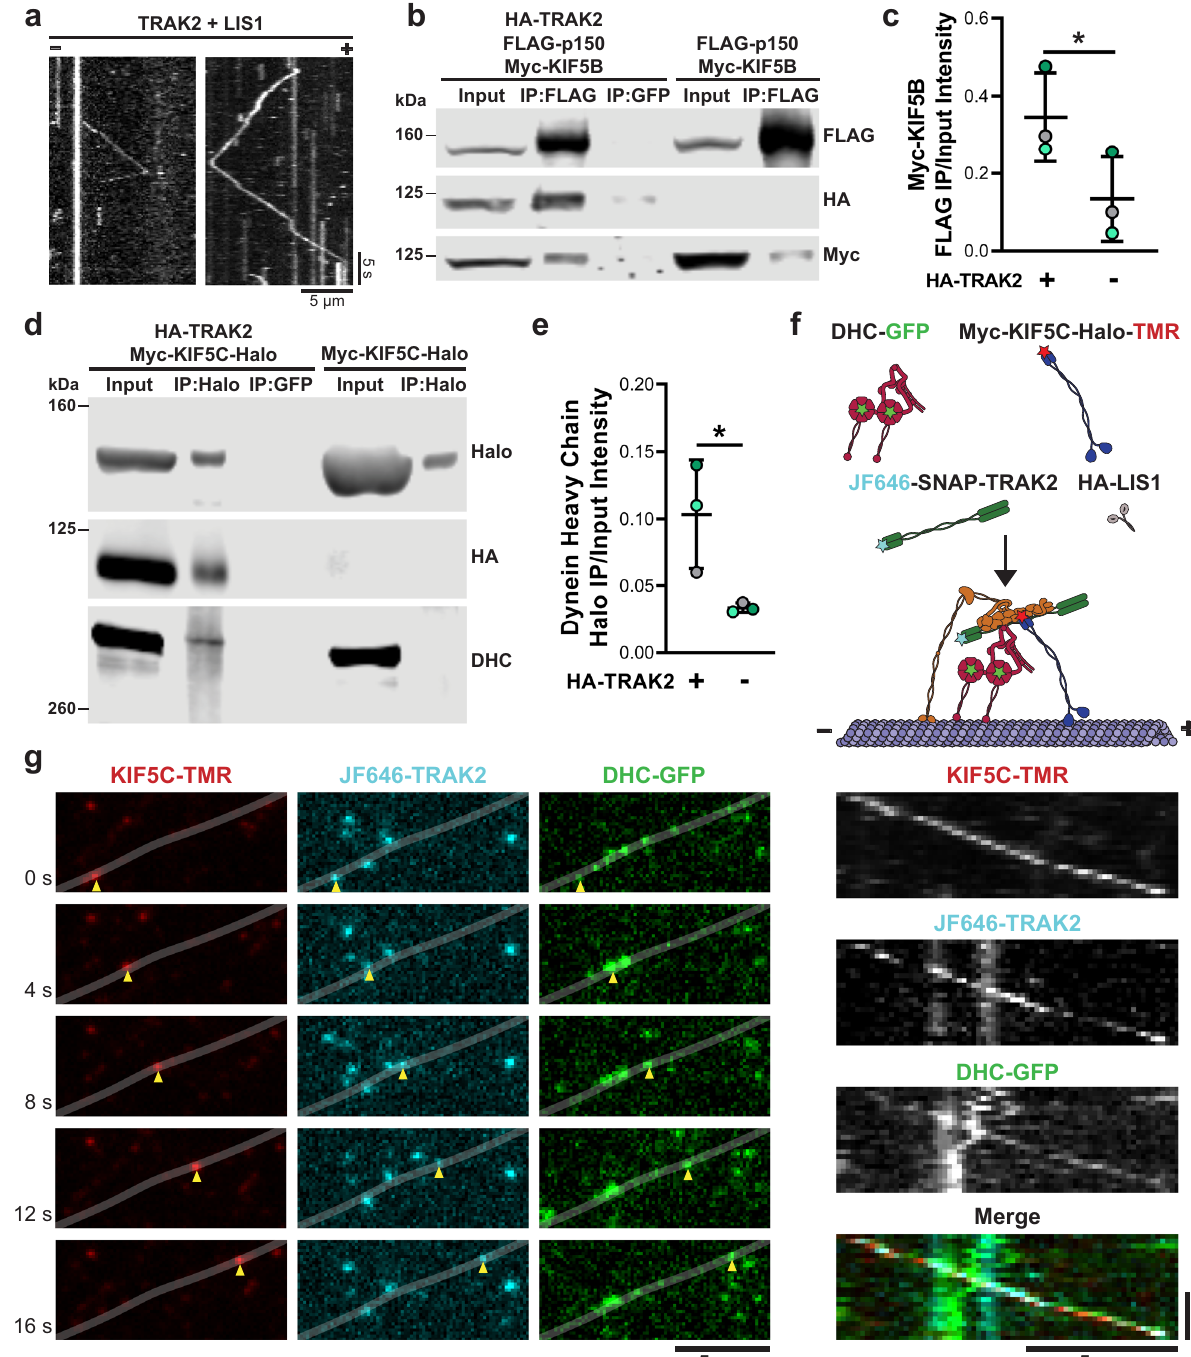
Fig. 5 TRAK2 forms a complex with kinesin-1, dynein, and dynactin. a Representative kymographs show TRAK2-motor complexes switching direction during a run. b Lysates from COS-7 cells transfected with HA-TRAK2, FLAG-p150 Glued , and Myc-KIF5B were immunoprecipitated with a FLAG antibody or negative control GFP antibody. Lysates from COS-7 cells expressing just FLAG-p150 Glued and Myc-KIF5B were immunoprecipitated with a FLAG antibody in parallel. c Quanti fi cation of the difference in Myc-KIF5B co-immunoprecipitation with FLAG-p150 Glued upon addition of HA-TRAK2. Data points are colored according to experimental replicate. Bars represent mean ± s.d. from three independent experiments. * p = 0.0405 (two-tailed t -test). d Lysates from COS-7 cells transfected with HA-TRAK2 and Myc-KIF5C-Halo were immunoprecipitated with a Halo antibody or negative control GFP antibody. Lysates from COS-7 cells expressing just Myc-KIF5C-Halo were immunoprecipitated with a Halo antibody in parallel. e Quanti fi cation of the difference in dynein heavy chain co-immunoprecipitation with Myc-KIF5C-Halo upon addition of HA-TRAK2. Data points are colored according to experimental replicate. Bars represent mean ± s.d. from three independent experiments. * p = 0.0410 (two-tailed t -test). f Schematic illustration for three-color single- molecule imaging of GFP-dynein heavy chain, Myc-KIF5C-Halo labeled with TMR, and SNAP-TRAK2 labeled with Janelia Fluor 646. HA-LIS1 is also present in this experiment. g Time series showing a processive complex containing KIF5C, TRAK2, and dynein heavy chain. The gray line indicates microtubule position, as inferred from the max projection of KIF5C. Right: corresponding